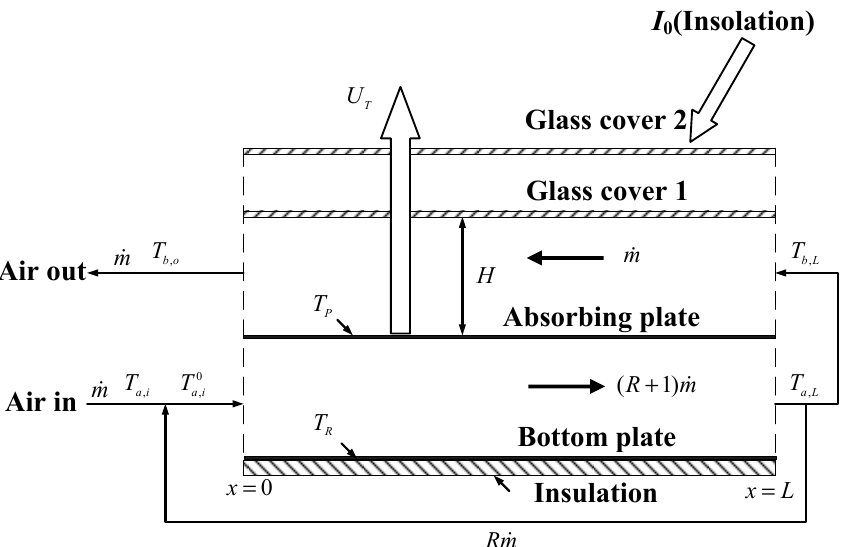
Figure 1. Double-pass solar air heater with internal baffles and